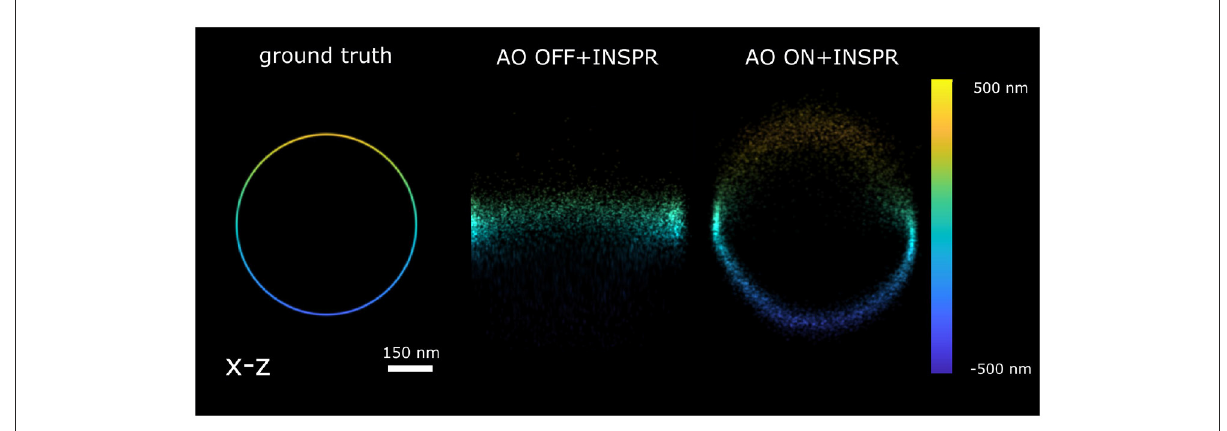
FIGURE5 Reconstruction x-z cross-section of the 3D ring localized by AO OFF and AO ON INSPR PSF model. ground truth: the x-z view of 3D ring. AO OFF+INSPR: the reconstruction image without AO correction, but in-situ PSF estimated using the INSPR algorithm. AO ON+INSPR: the reconstruction image with AO and the in-situ PSF estimated using the INSPR